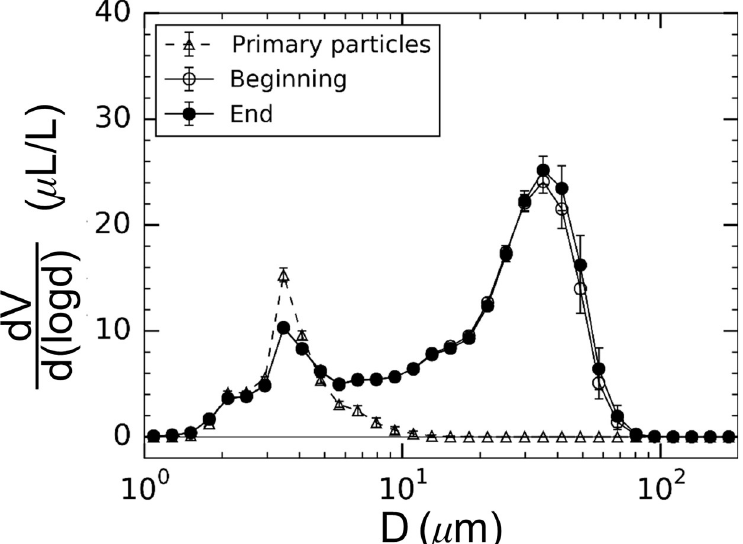
Fig 3. Size-spectra of particle volume for the primary particles and flocs in the aggregation tank measured with the LISST-100X. Consistency of floc size distribution during experimentation is shown with measurements obtained nine hours apart during continuous facility operation. Error bars represent one standard